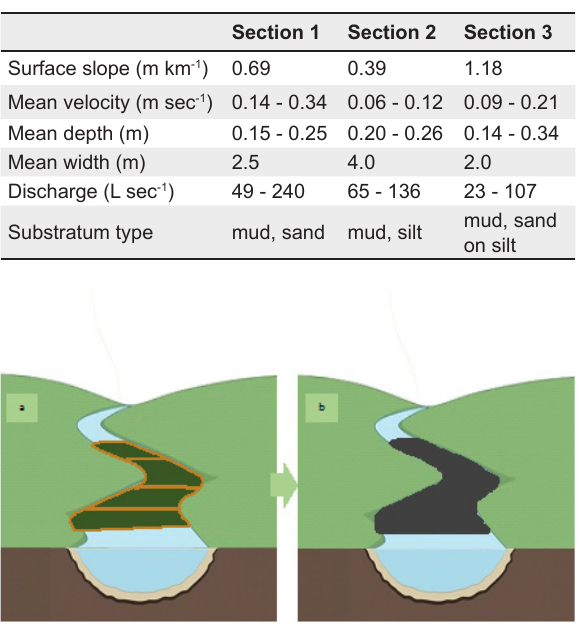
Table 1. Hydraulic and hydrometric data for the three sections studied in the Suså watershed